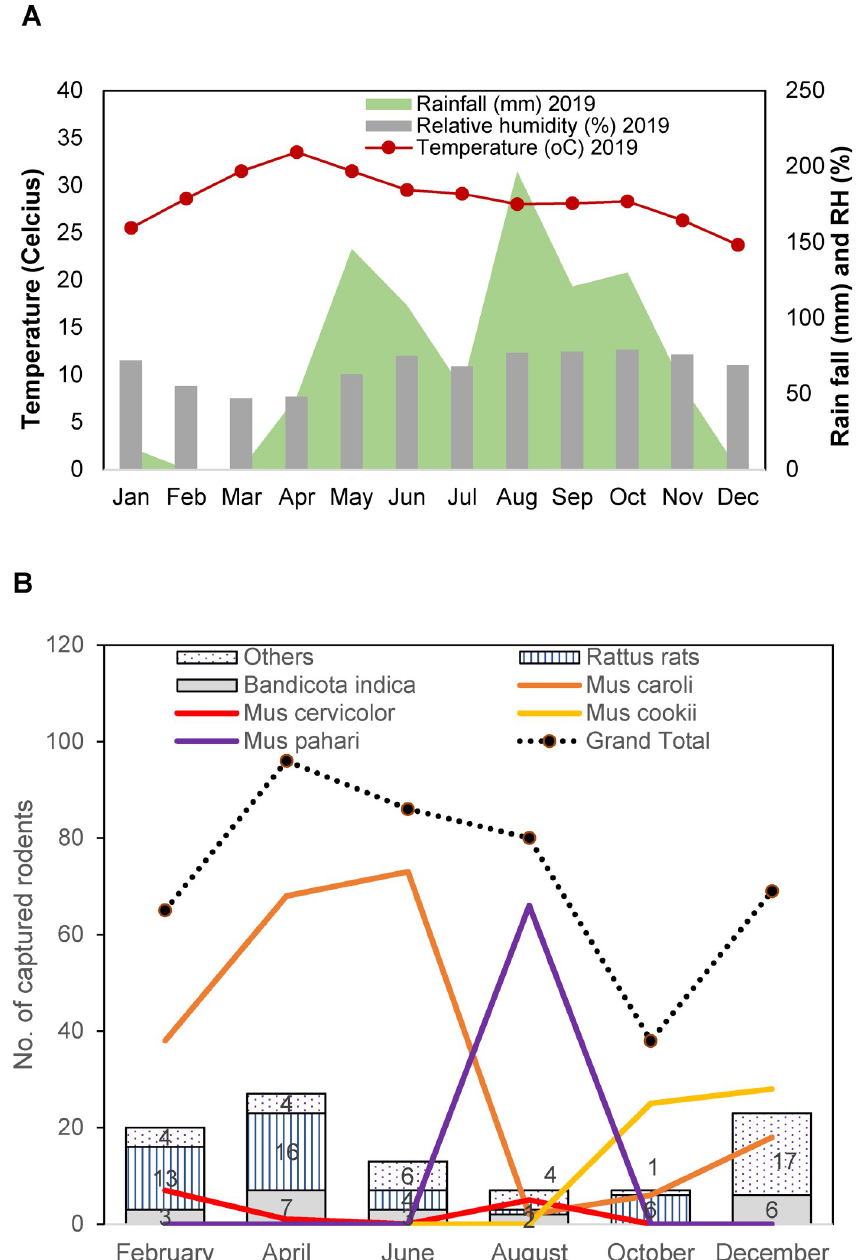
Fig 1. Rainfall (mm) and temperature (˚C) during the year 2019 in Phop Phra district, Tak province in 2019 (A). The density and distribution of rodent species captured over one year period in Wale sub-district, Phop Phra district, Tak province in 2019